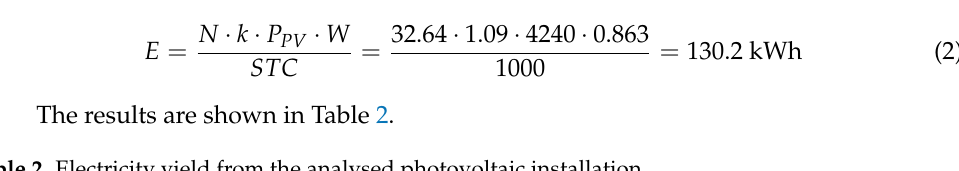
Table 2. Electricity yield from the analysed photovoltaic